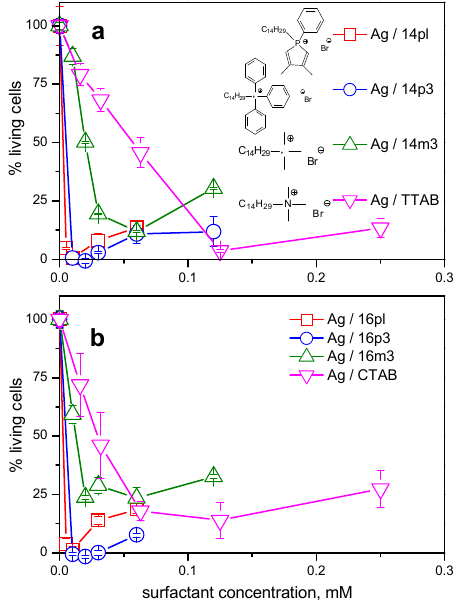
Figure 11. Effect of surfactant headgroup composition on cytotoxic activity at the fixed alkyl chain length. Cytotoxicity vs. surfactant concentration plots of AgNPs stabilized with alkyldimethylphenylphospholium ( pl ), alkyltriphenylphosphonium ( p3 ), alkyltrimethylphosphonium ( m3 ) and alkyltrimethylammonium (TTAB and CTAB) surfactants. The alkyl chain length ( a ): C 14 ( b ): C 16 . The plots in Figure 11 indicate that AgNPs capped by pl and p3 surfactants are more active than AgNPs stabilized with trimethyl-substituted ammonium or phosphonium surfactants ( m3 , TTAB, CTAB), which is documented by the minimum percentage of sur- viving cancer cells attained at the lowest surfactant concentration among the investigated surfactants. This underlines the active role of phenyl substituents and heterocyclic phos- pholium ring in the increased cytotoxicity of AgNPs. Significant increase in cytotoxicity of AgNPs was found with the increasing number of phenyl substituents in phosphonium surfactant headgroup when the percentage of viable cells was found to be well below 1% for triphenyl-substituted phosphonium surfactants [52]. Another observation resulting from the plots is related to the fact that the cytotoxicity curves for Ag/ 14pl and Ag/ 14p3 almost overlap at small surfactant concentrations, while cytotoxic activity of Ag/ 16p3 is only slightly higher at larger surfactant concentration values (Figure 11). These findings emphasize high cytotoxicity of AgNPs stabilized with non-aromatic heterocyclic phos- phorus-based surfactants. The reported studies in the literature indicate that compounds